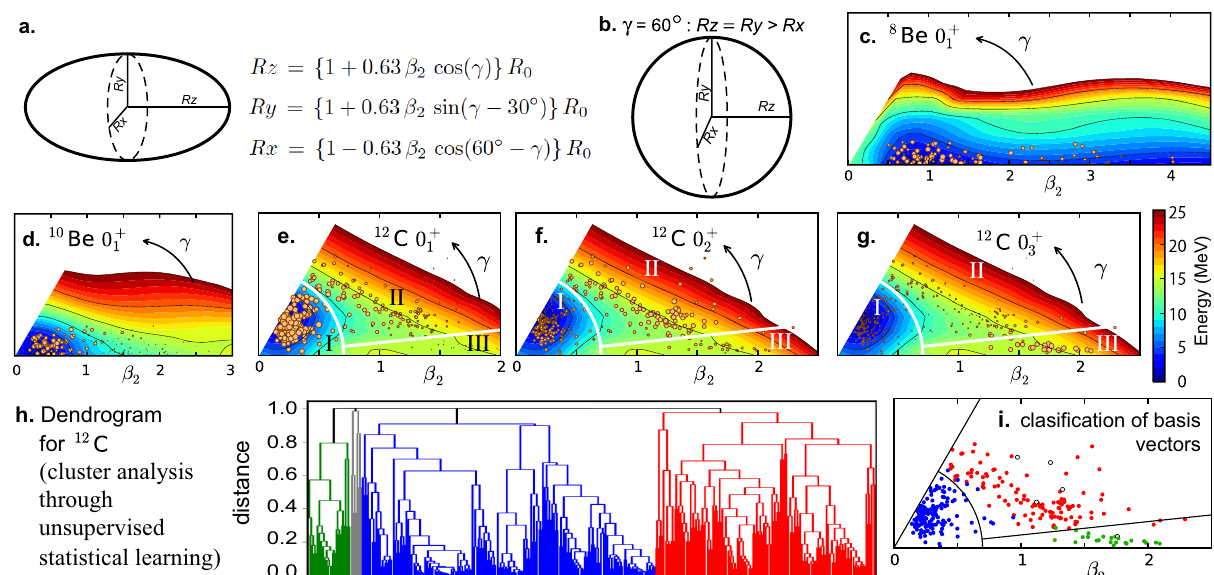
Fig. 4 Classi fi cation of MCSM basis vectors by T-plot and Statistical Learning methods. a De fi nition of parameters. The ellipsoid shows a prolate shape ( γ = 0 or R y = R x ). b An oblate shape. c , d Potential energy surface (PES) and T-plot for the ground state of 8,10 Be. e – g PES and T-plot for the 0 þ 12 C with the decomposition to regions I – III. h MCSM basis vectors analyzed by the dendrogram of cluster analysis through unsupervised statistical learning. i T-plot circles classi fi ed by the same color as in h